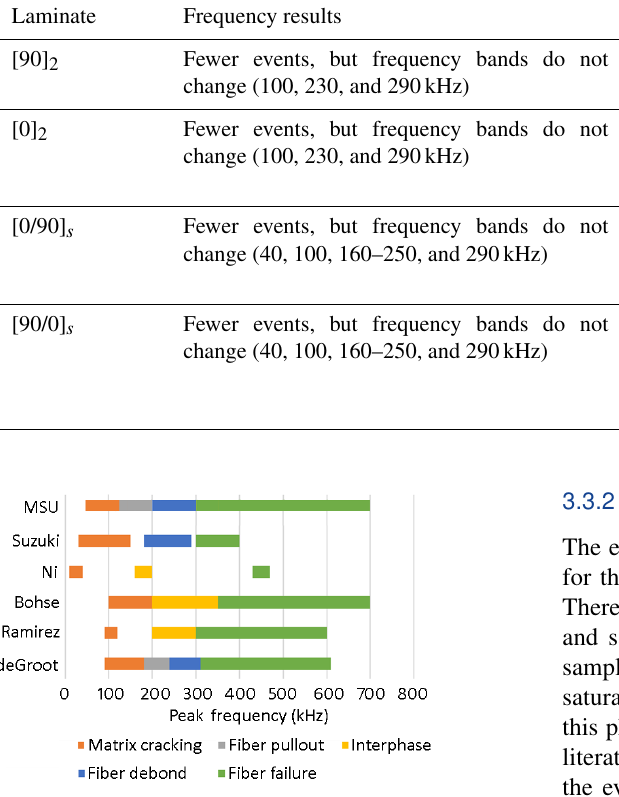
Figure 10. Frequency-damage mode correlations from various